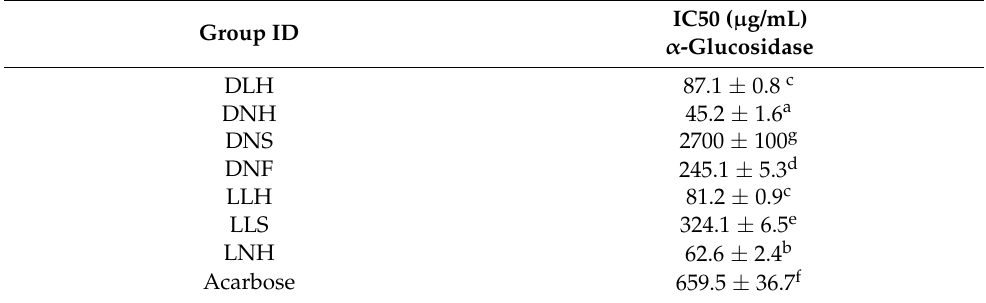
Table 4. IC 50 values of the active seaweed PHLE extracts against α -glucosidase at the assayed